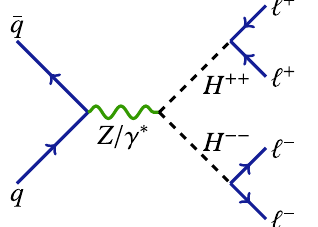
Fig. 1 Feynman diagram of the pair production process pp → H ++ H −− . The analysis studies only the electron and muon channels, where at least one of the lepton pairs is e ± e ± , e ± μ ± , or μ ± μ ±